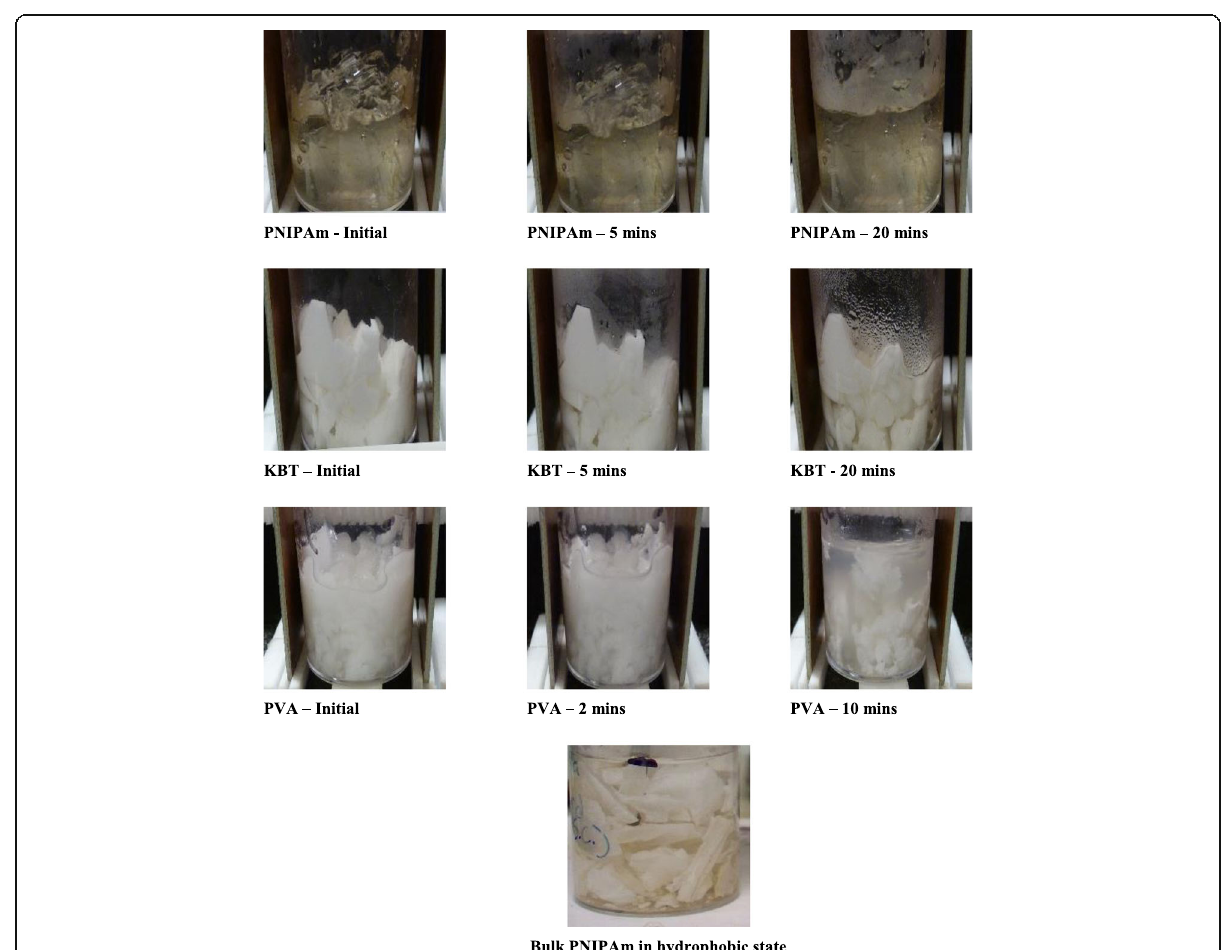
Fig. 6 Time-dependent response of PNIPAm, PVA, and KBT to applied RF. Images of PNIPAm, KBT, and PVA hydrogels undergoing exposure to RF at 544.4 kHz in a parallel plate antenna setup. Bulk PNIPAm (top) does not show any discernible volumetric change while KBT (2nd row) and PVA (3rd row) show RF-induced volumetric changes. PVA undergoes the most extensive volumetric phase change within 10 min of application, while KBT at 20 min of application. Bulk PNIPAm after undergoing its phase change attained using conductive heating